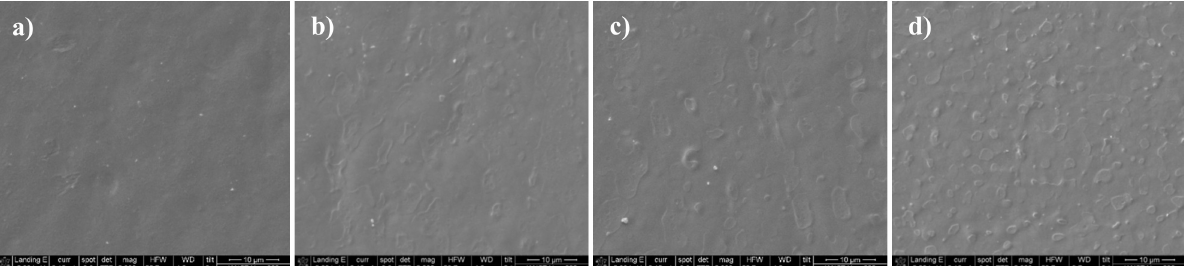
Figure 9. SEM images of ( a ) 0 wt%, ( b ) 3 wt%, ( c ) 5 wt%, and ( d ) 9 wt% DMSO paste film.